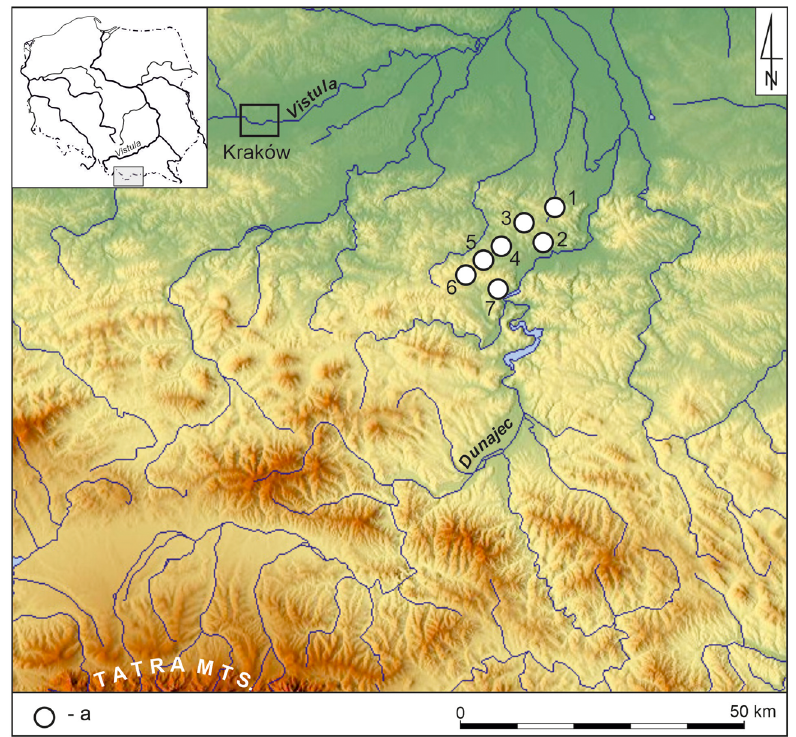
Figure 1: Neolithic excavation sites: ( a ) on the left bank of the middle Dunajec river. ( 1 ) Gwo ź dziec, com. Zakliczyn, site 2; ( 2 ) Ż erków, com. Gnojnik, site 1; ( 3 ) Ł oniowa, com. D ę bno, site 18; ( 4 ) Biesiadki, com. Gnojnik, site 16; ( 5 ) Tworkowa, com. site 20; ( 6 ) Czchów, com. loco, site 10; ( 7 ) Jurków, com. Czchów, site